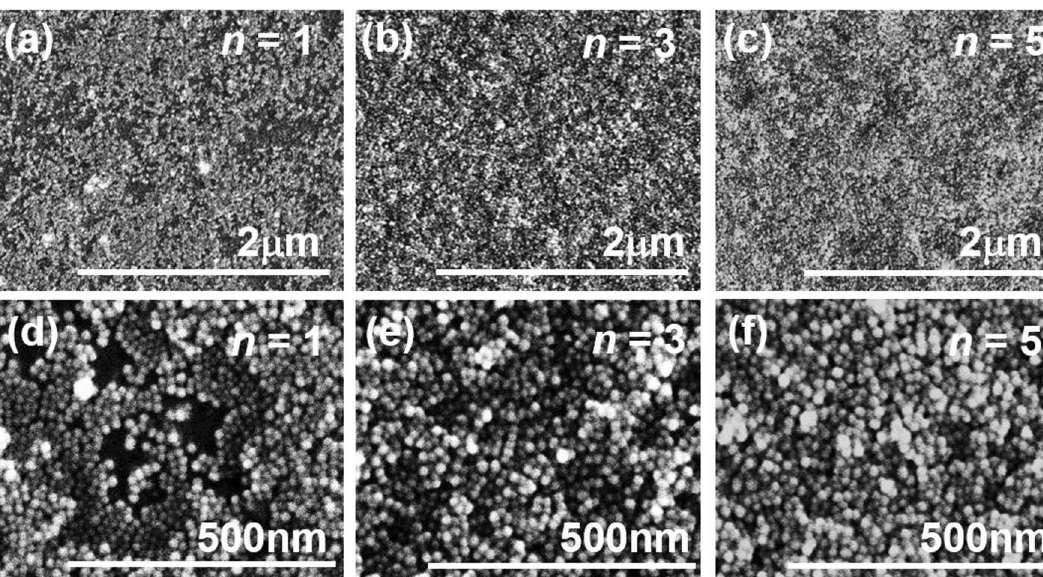
Figure 4. SEM images of the [Ta film/Fe 3 O 4 nanoparticle] n films on the polyimide sheet annealed at T A = 473 K with ( a ) n = 1, ( b ) n = 3, and ( c ) n = 5. ( d ), ( e ), and ( f ) are enlarged SEM images of ( a ), ( b ), and ( c ),